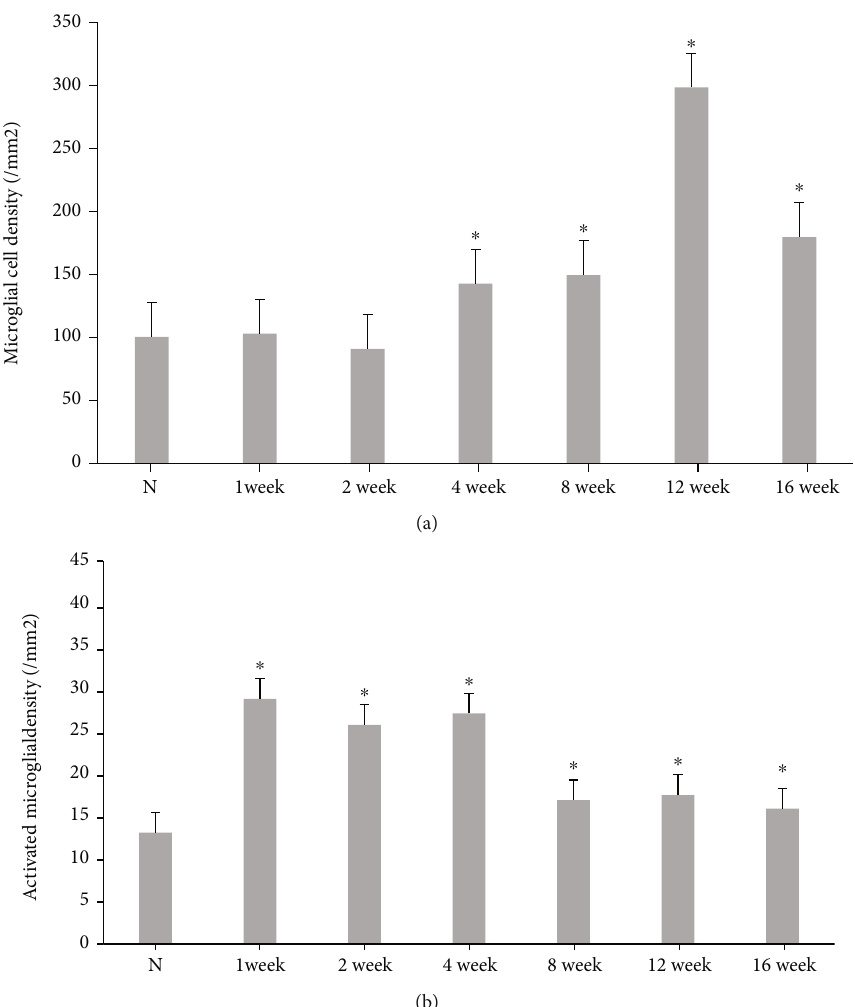
Figure 3: Density of total microglia (a) and activated microglia (b) in the retinas of control and diabetic rats. ∗ p < 0 : 05 versus